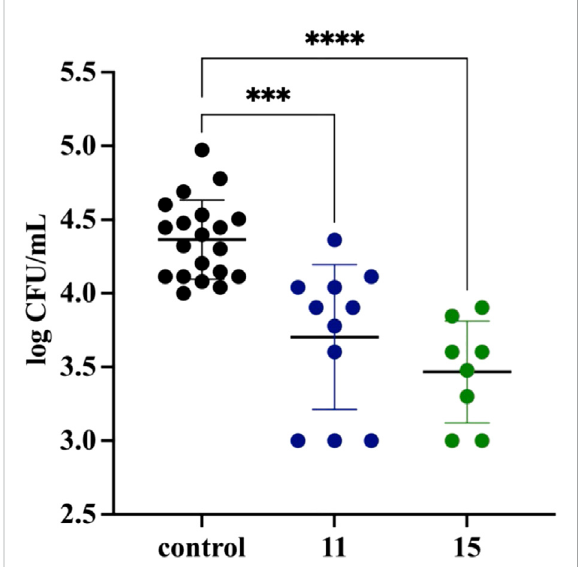
FIGURE 1 Inhibitory effect of compounds 11 and 15 on the intracellular growth of M. tuberculosis in human monocyte-derived macrophages. The intracellular growth of the pathogen in the experimental (11/15-treated) samples versus the control (untreated)sampleispresentedasalogCFU/mL,whichrepresents the ratio of the CFU number determined for the 11 (blue) and 15 (green) treated samples to the CFU number estimated in the control sample. Error bars indicate standard deviations. Data were analyzed using the Mann – Whitney U test. The differences between control cells and compound-treated samples were statistically signi fi cant, with p = 0.0006 (***) and p < 0.0001 (****) for compounds 11 and 15, respectively. The statistical analysis was done using SigmaStat v.